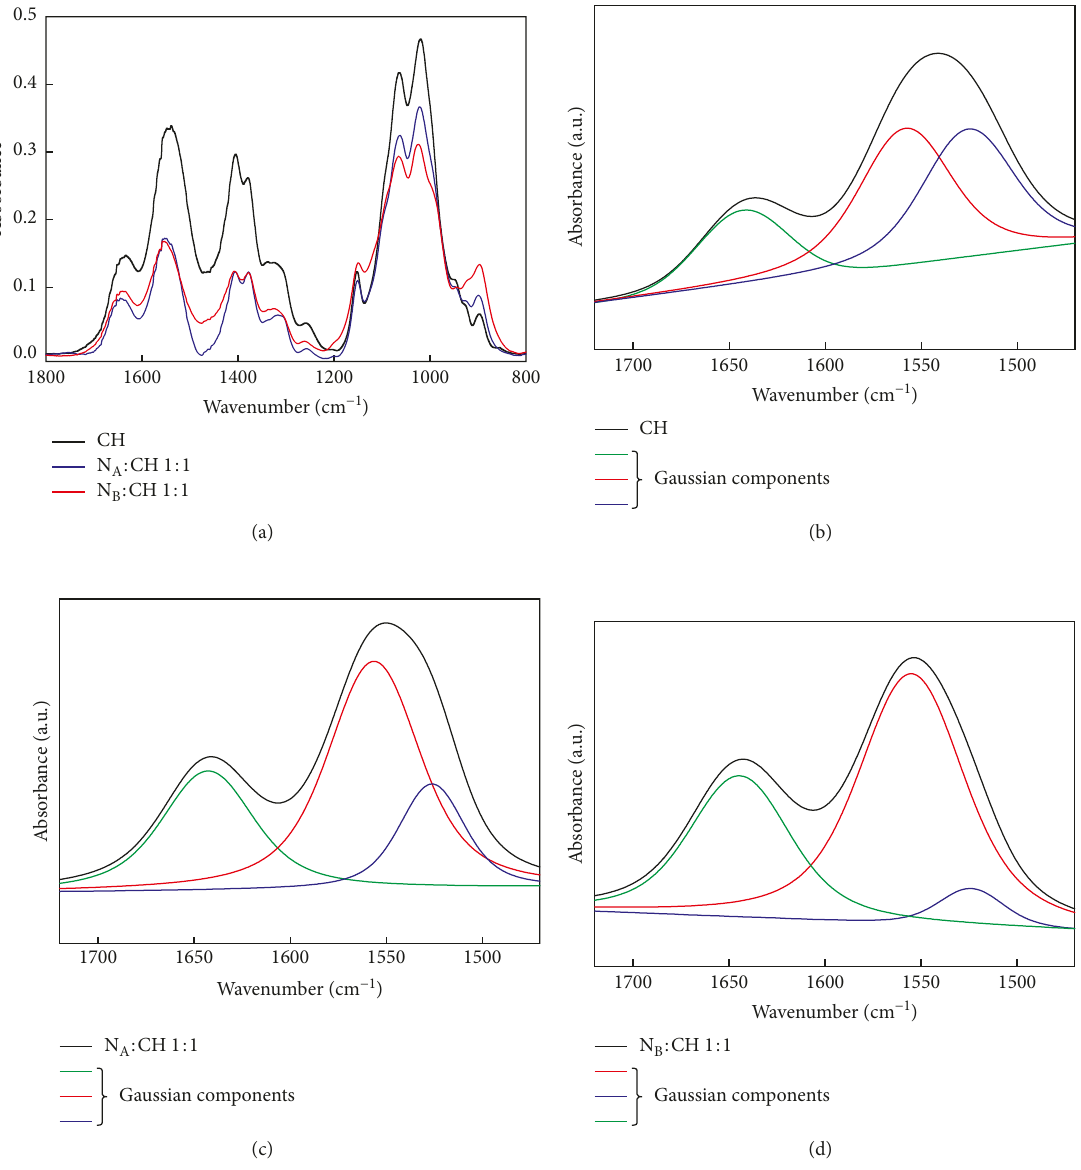
1 (A,B) : CH ratio showing the region 1800–800cm −